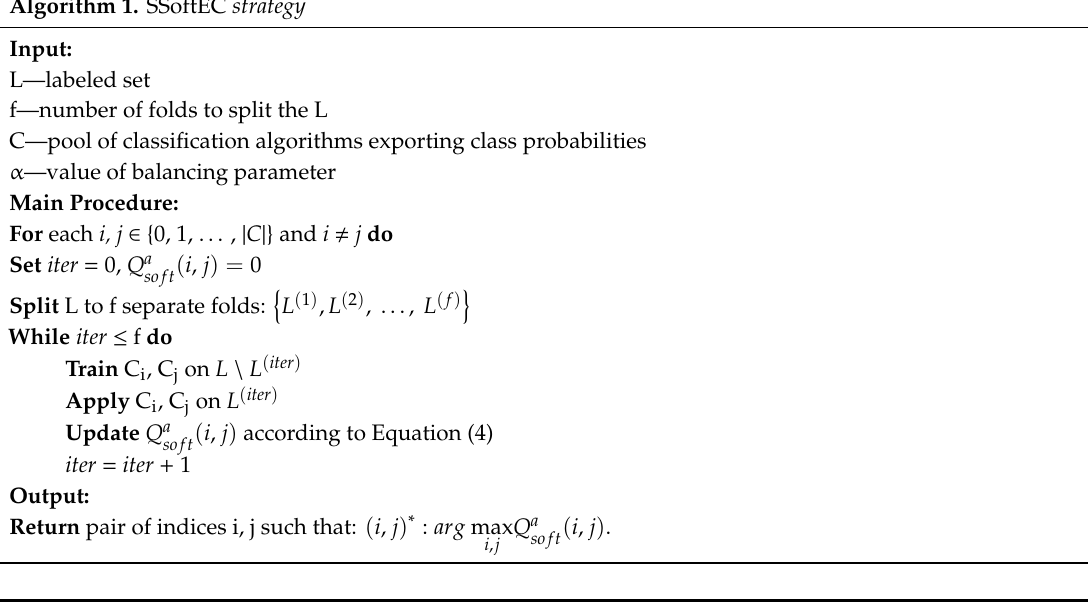
Algorithm 2. Ensemble based co-training